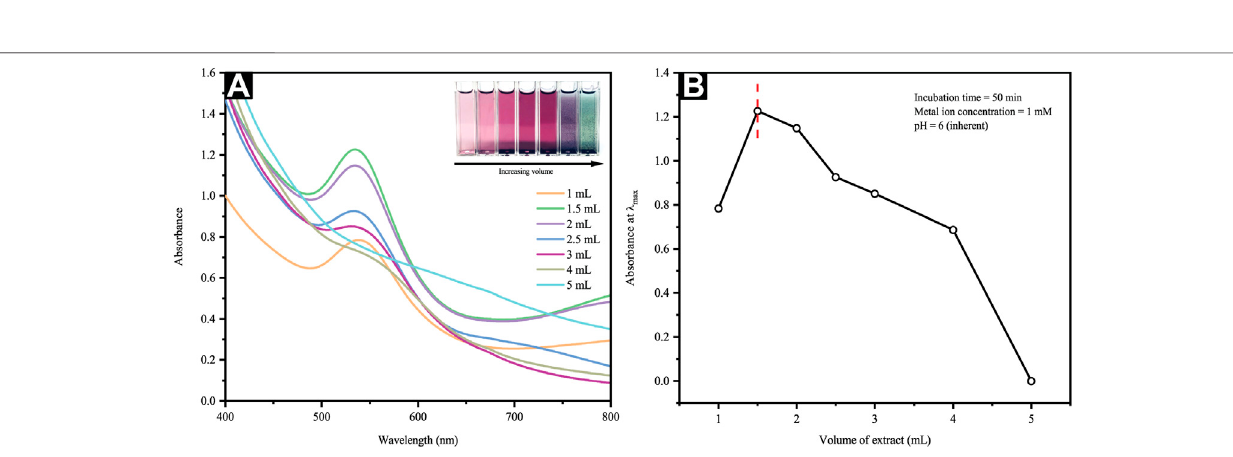
Frontiers in Chemistry |